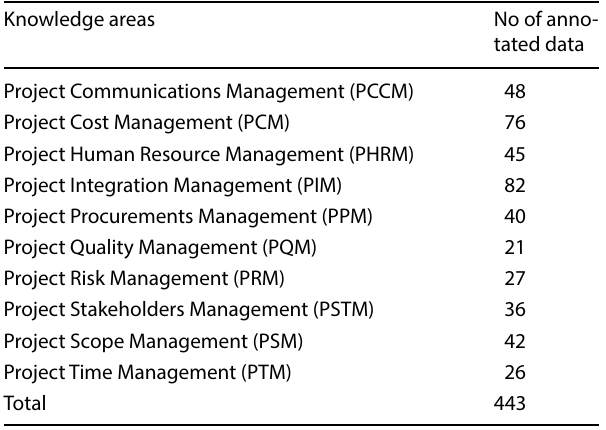
Table 1 Project management knowledge areas failures after anno- tating the data Knowledge